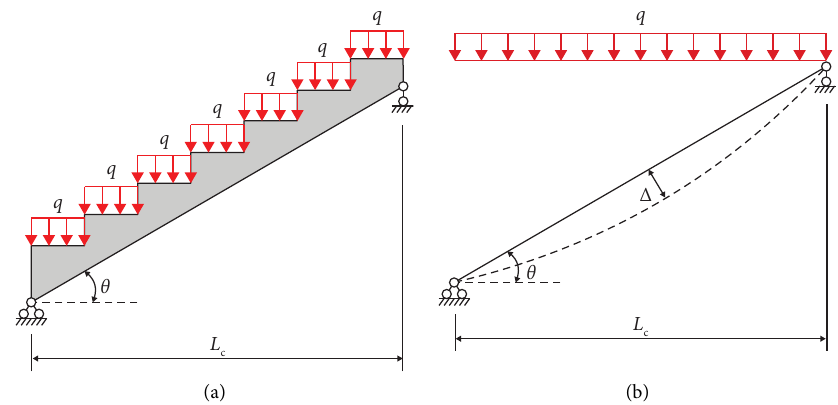
Figure 8: Te simplifed stair slab model during design. (a) Te uniformly distributed loads on the treads of the stair slab. (b) Te simply supported beam